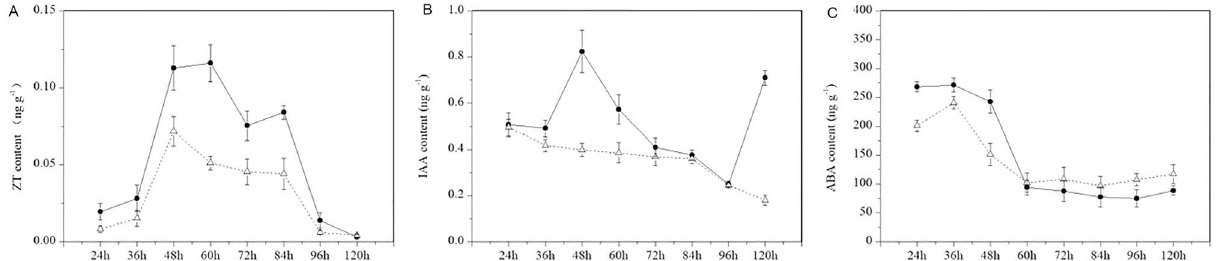
Figure 3. Hormone content in SP and OP. ( A ) Zeatin, ZT. ( B ) Auxin, IAA. ( C ) Abscisic acid, ABA.